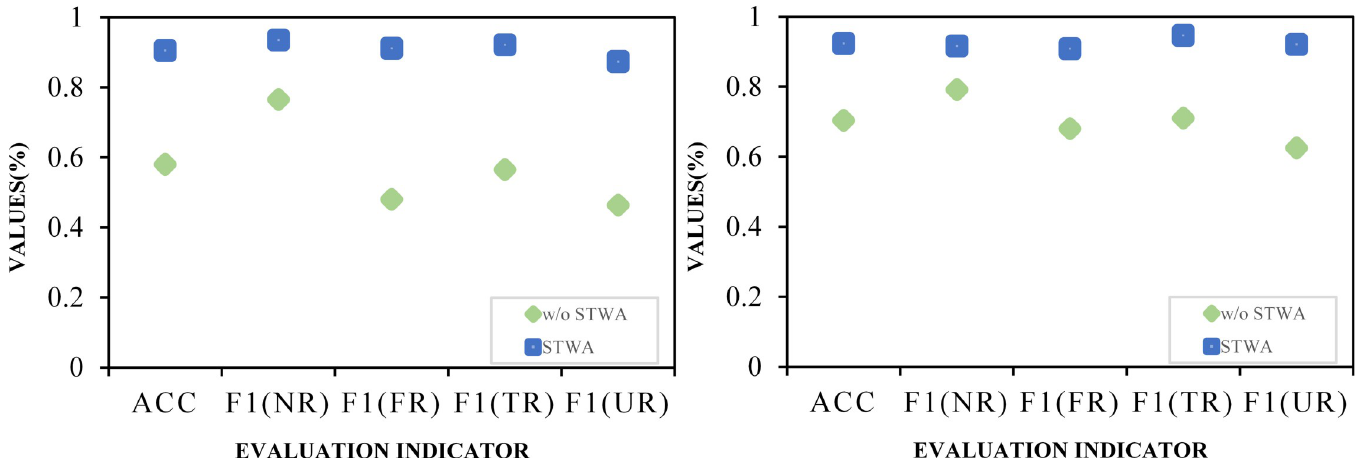
Fig 6. The importance analysis of Source tweet-word graph attention networks. (a) Ablation study (On Twitter15). (b) Ablation study (On Twitter16).